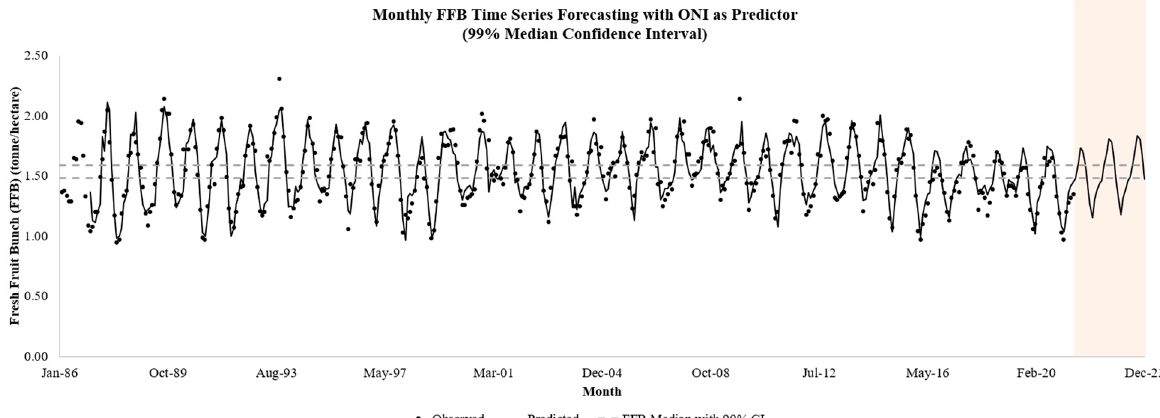
Figure A1. FFB time series, ARIMA (2,0,2) (1,1,1) model with ONI as predictor (adjusted R-squared = 0.8274). Modelled period: February 1986 to June 2021 (N = 425). 30 months forecasted period: July 2021 to December 2023 (N = 30, highlighted area of Figure A1). Note: Dash lines represent BCa 99% confidence interval range of monthly oil palm yield in Malaysia. FFB model predicts monthly oil palm yield to fluctuate around the BCa 99% confidence interval range in next 30 months.